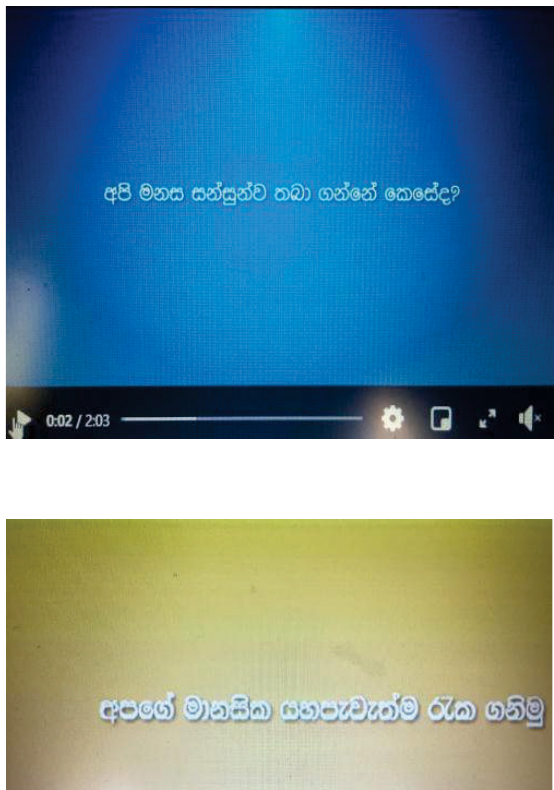
Figure 1: Promoting emotional intelligence for psychological